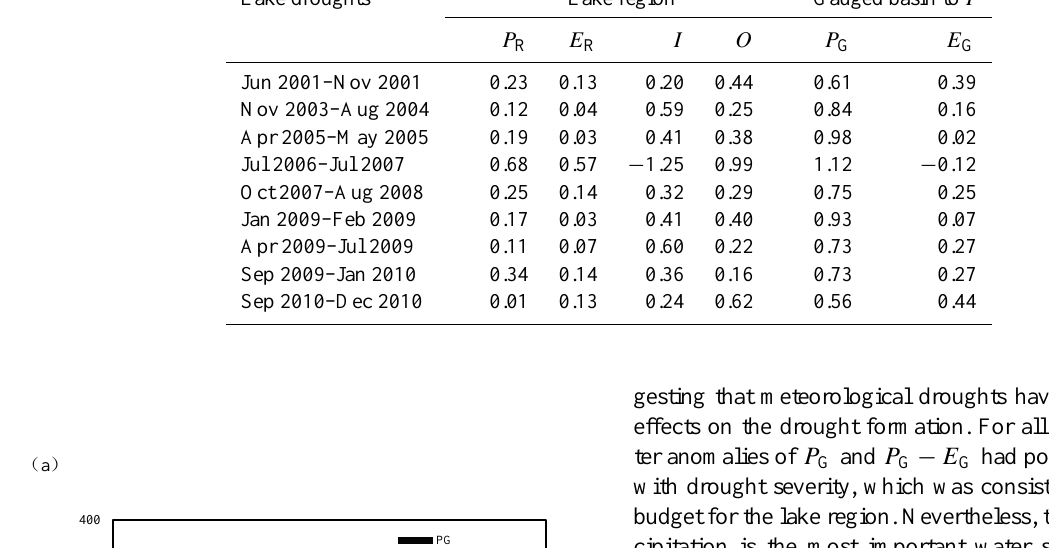
Table 3. Contribution of each water component (unit in 100%) to the total water anomaly up the time of peak drought (highest drought intensity) for the lake region and gauged basin. Lake droughts